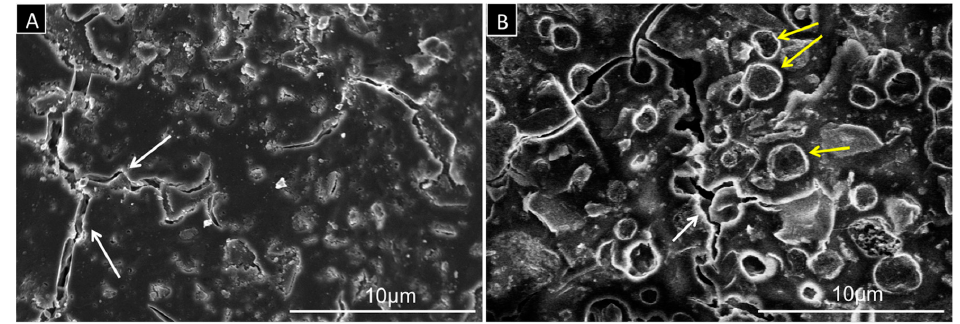
Figure 5. SEM images at 5000× magnification of ( A ) pure cement (control group); and ( B ) modified cement (10% smart capsules). Microcracks with a width of 0.1–2 μ m are clearly visible in both groups (white arrows). The modified cement shows relatively well-distributed spherical structures representing the smart capsules (yellow arrows).